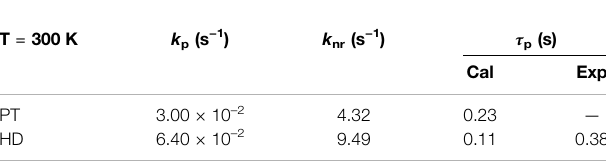
TABLE 1 | Calculated radiative k p and nonradiative decay rates k nr of T 1 → S 0 , as well asthe RTP lifetime τ p (cid:1) 1/( k p + k nr ) for PT and HD. The experimental value was also given as a